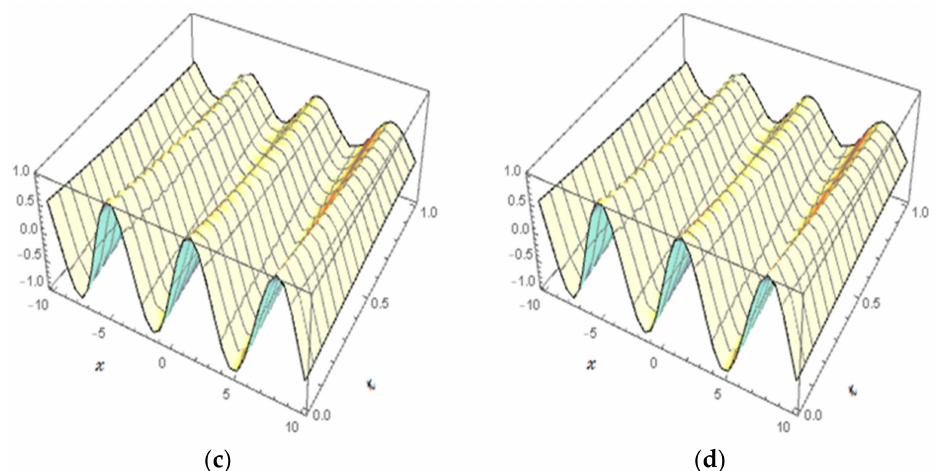
Figure 2. 3D-Surfaces plot of exact solutions ( U ( 𝓍 , 𝓉 ) , V ( 𝓍 , 𝓉 )) , and the 7 − th approximate so- lutions ( U 7 ( 𝓍 , 𝓉 ) , V 7 ( 𝓍 , 𝓉 )) , for system (20), with 𝓉 ∈ [ 0,1 ] , and 𝓍 ∈ [ − 10,10 ] , at various val- ues of 𝒶 . ( a ) ( U ( 𝓍 , 𝓉 ) , V ( 𝓍 , 𝓉 )) . ( b ) ( U 7 ( 𝓍 , 𝓉 ) , V 7 ( 𝓍 , 𝓉 )) : 𝒶 = 1. ( c ) ( U 7 ( 𝓍 , 𝓉 ) , V 7 ( 𝓍 , 𝓉 )) : 𝒶 = 0.95. ( d ) ( U 7 ( 𝓍 , 𝓉 ) , V 7 ( 𝓍 , 𝓉 )) : 𝒶 = 0.85.